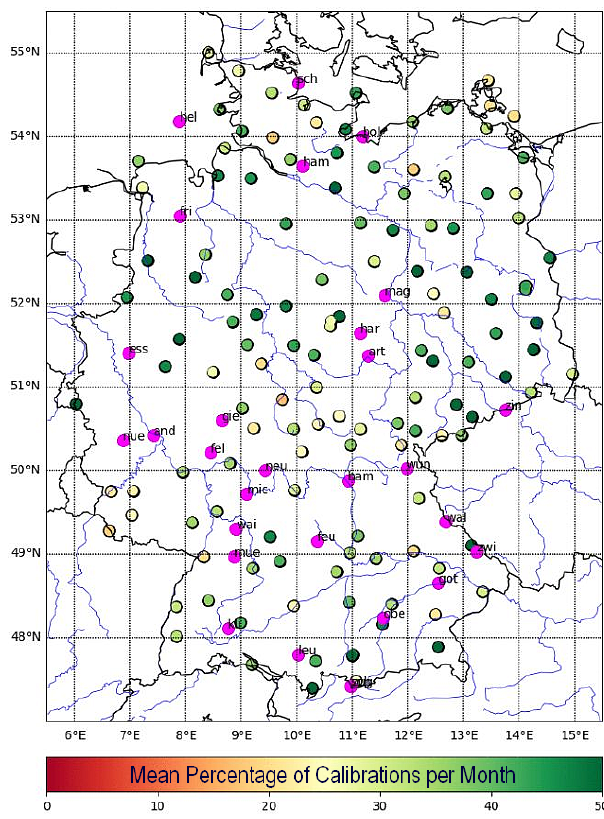
Figure 1. Lufft-CHM15k ceilometer network of the Deutscher Wet- terdienst (DWD) in 2020, color coded by the number of avail- able calibrations per month. Pink dots denote stations without cal- ibrated data. Near-real-time QuickLooks and metadata informa- tion are available via http://www.dwd.de/ceilomap/ (last access: 25 March